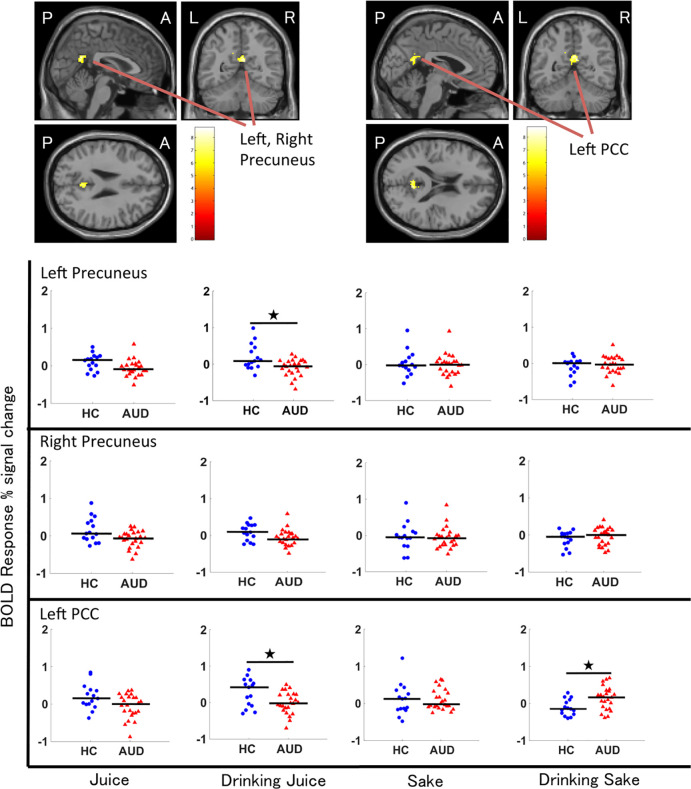
Regions where fMRI analyses revealed significant stimuli-by-group interactions.Coloured bars represent the F-values of the interactions (cluster-level FWE-corrected p < 0.05). The scatter diagram shows the BOLD responses to the four beverage images (juice, drinking juice, sake, and drinking sake) in healthy controls (marked “HCs”; n = 15, blue dots) and participants with AUD (marked “AUD”; n = 24, red dots) in the left precuneus, right precuneus, and left PCC. The bars show the median values. ★p < 0.05.